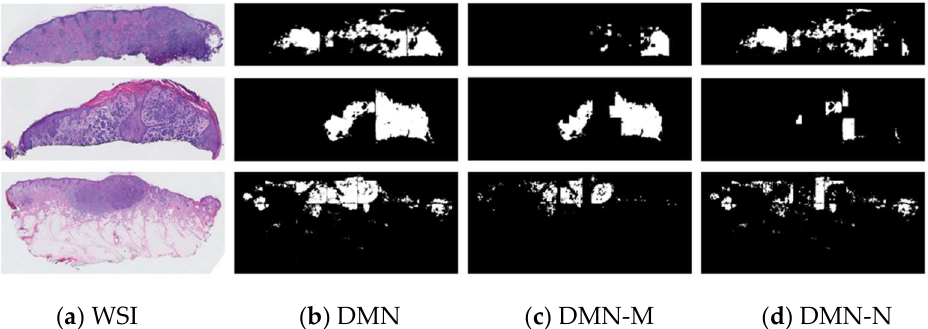
Figure 9. Examples of our best nest classifier, ResNet’s results on WSI: ( a ) extracted slices of invasive melanoma WSIs; ( b ) dermal nest results of segmentation model; ( c ) melanoma dermal nest (DMN-M) portion of DMN; ( d ) nevus dermal nest (DMN-N) portion of DMN.